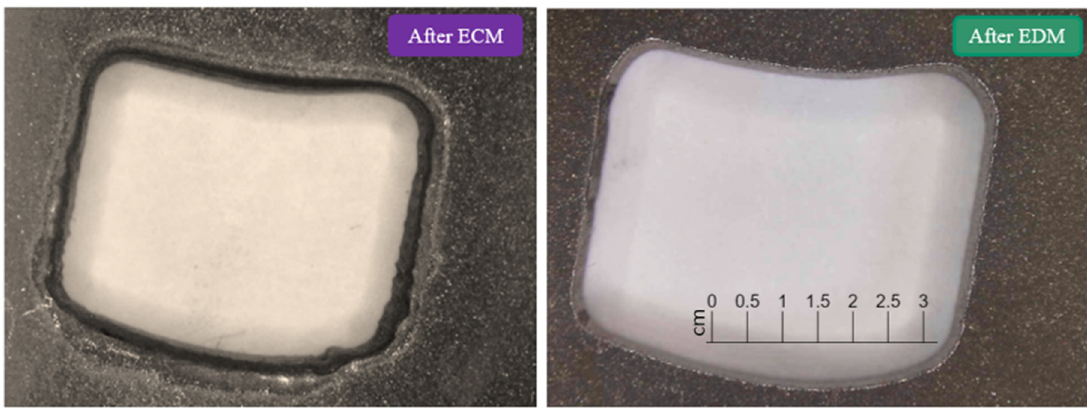
Figure 13. Comparison before and after processing. Table 4. Averages of the feature values.